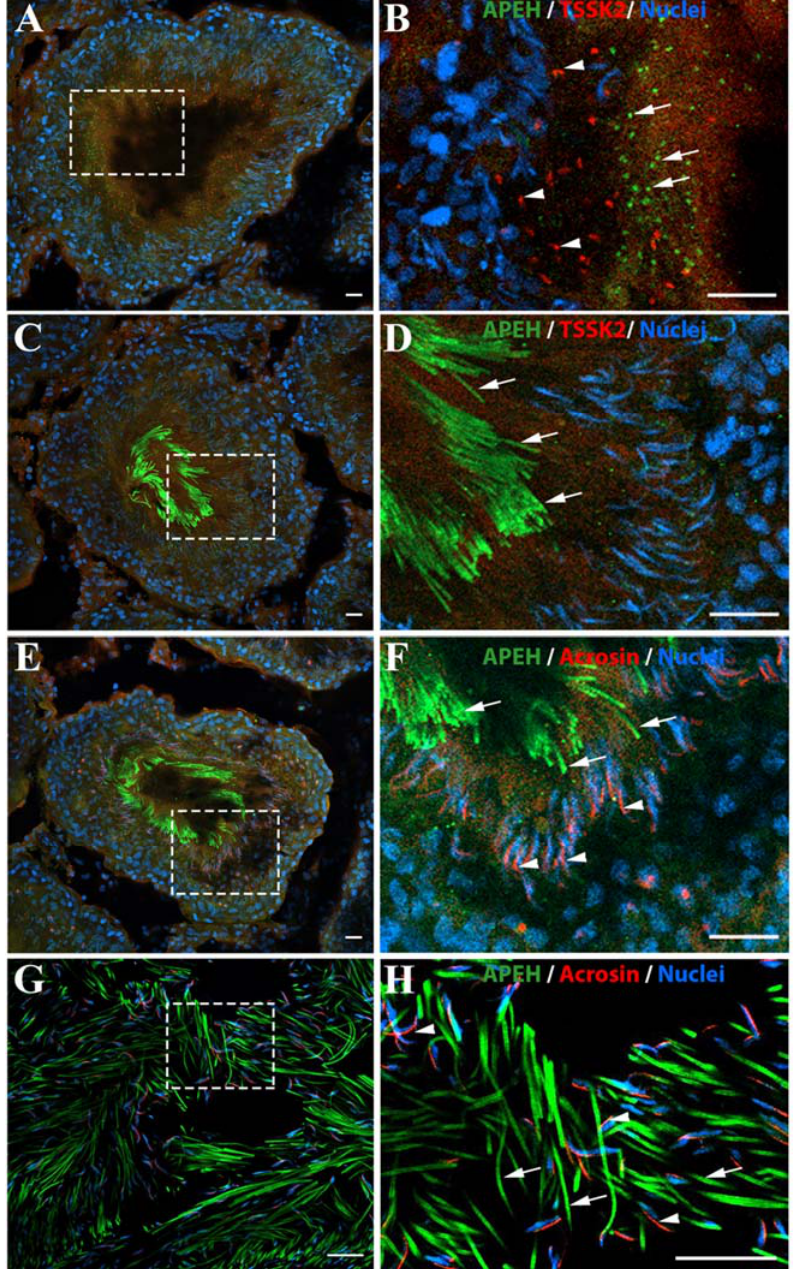
Figure 2. Distribution of APEH in testis and epididymis from male rats. Testis and epididymis cryosections were subjected to immunofluorescence against APEH (green). ( A ) Seminiferous tubule representative of stages IX–XIV, using an antibody against TSSK2 (testis specific serine/threonine-protein kinase 2, red) as an early spermatid marker. ( B ) Selected zoom of the immunofluorescence in A. White arrows show the APEH signal in punctate structures and white arrowheads indicate TSSK2 signal in punctate structures. No colocalization of TSSK2 with APEH is observed. ( C ) Seminiferous tubule representative of stages I-VIII using the TSSK2 marker. ( D ) Selected zoom of the immunofluorescence in C. White arrows show the APEH signal in the tails of elongated spermatids in final maturation stage. However, the TSSK2 signal was lost in these stages. ( E ) im- munofluorescence in stage I-VIII seminiferous tubules using APEH (green) and acrosin (Red) anti- bodies. ( F ) Selected zoom of the immunofluorescence in E. Acrosin is localized to the heads of elongated spermatids in final maturation stage (white arrowheads), while, as before, APEH signal was observed in the tails (white arrows). ( G ) Epididymal cauda immunofluorescence against